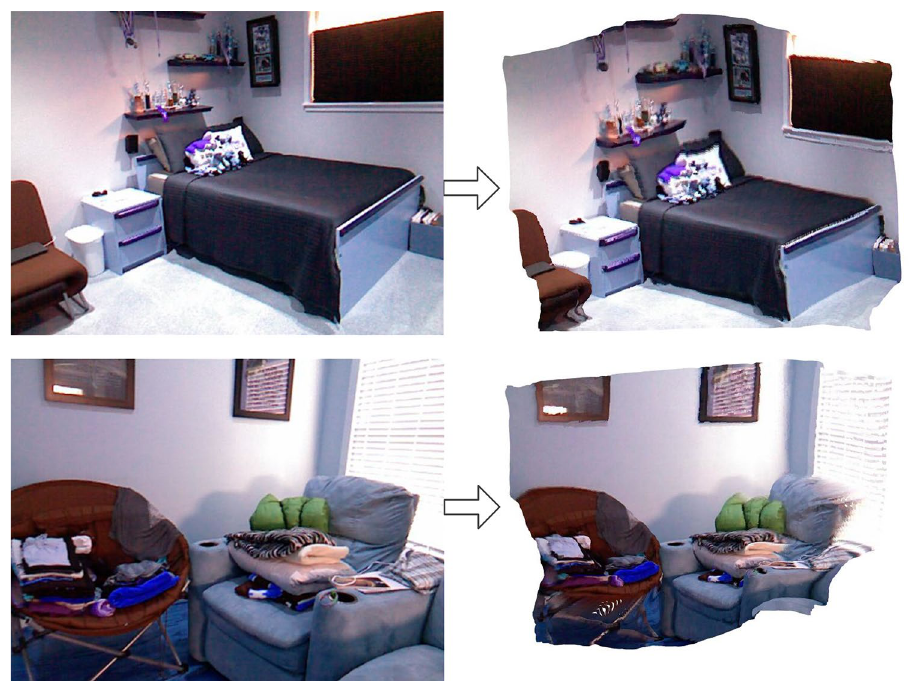
Figure 6. Depth predicted by the proposed model generates a 3D point cloud result.